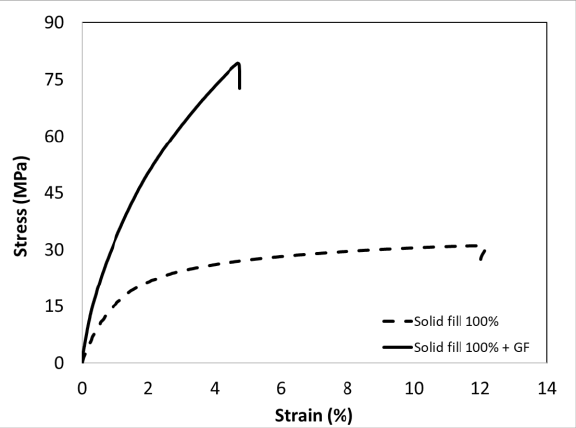
Figure 14. Quasi-static tensile curves of CF-PA6 (Onyx) and CF6-PA6 reinforced with continuous